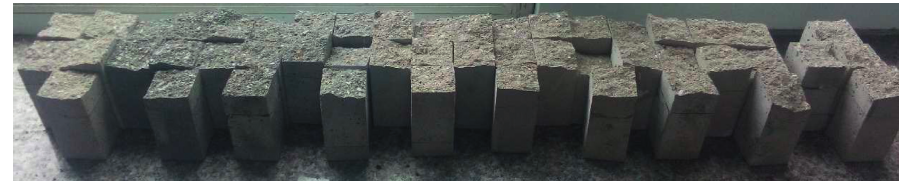
Figure 13: Test of mortar with different dosage of three kinds of OSWA. Table 9: The number of gelled material specimens.